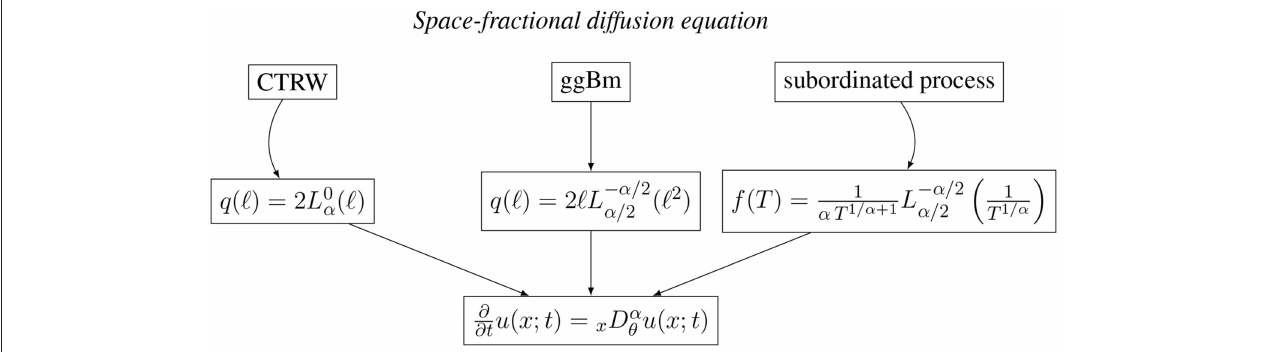
FIGURE 1 | Schematic picture of the three stochastic processes in heterogenous media leading to the same space-fractional diffusion equation for the 1-point 1-time PDF.